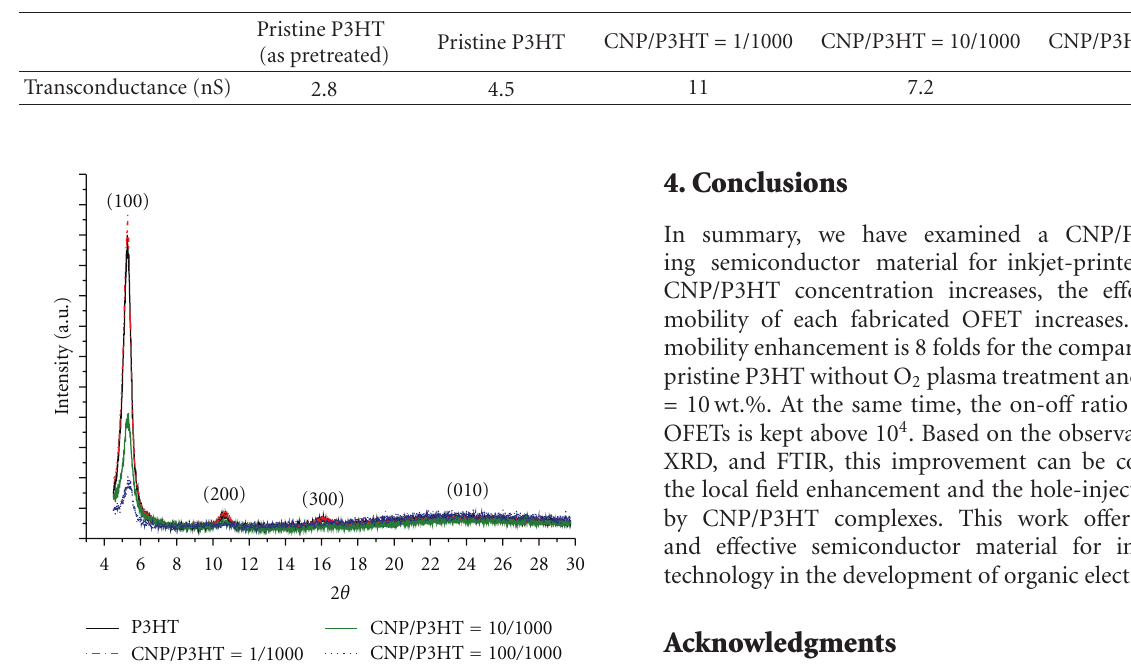
Table 2: The experimental transconductance of developed OFETs.